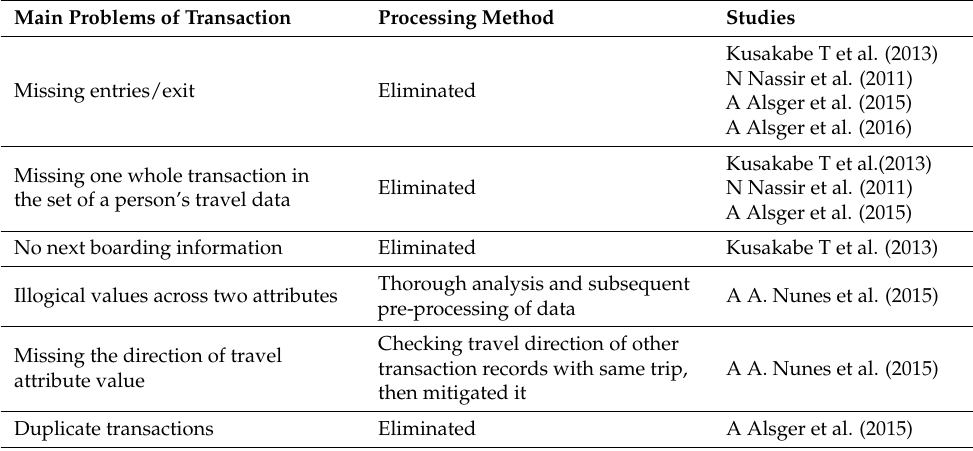
Table 7. Summary of problems with data from smart card.